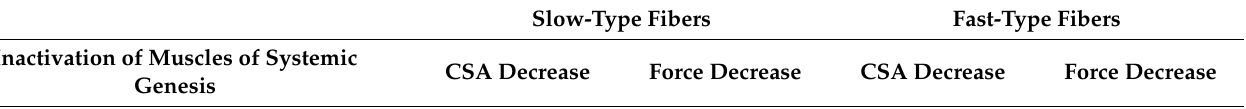
Table 1. Classification of the types of in vivo inactivation of skeletal